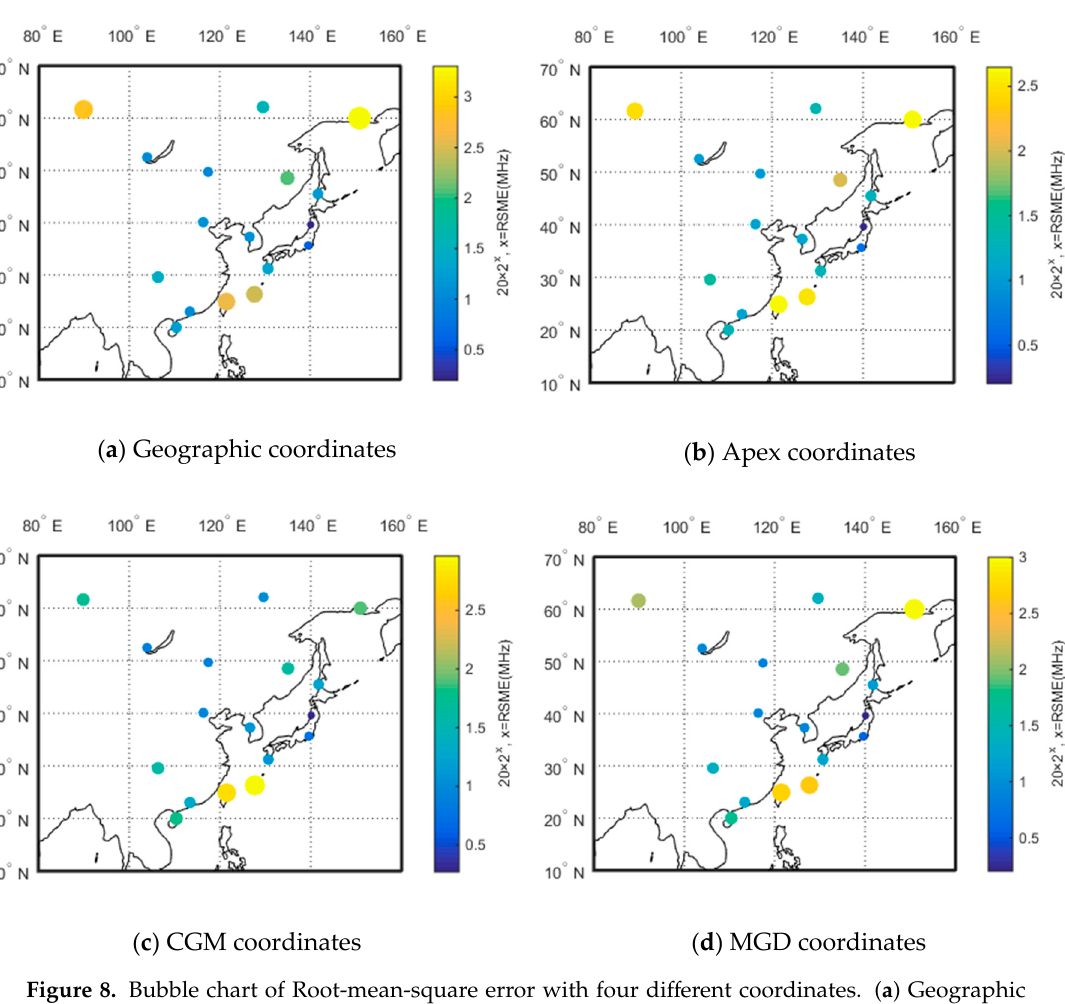
Figure 8. Bubble chart of Root-mean-square error with four different coordinates. ( a ) Geographic coordinates, ( b ) Apex coordinates, ( c ) CGM coordinates, and ( d ) MGD coordinates. The radius of bubbles is set by 20×2 RSME for better comparison.